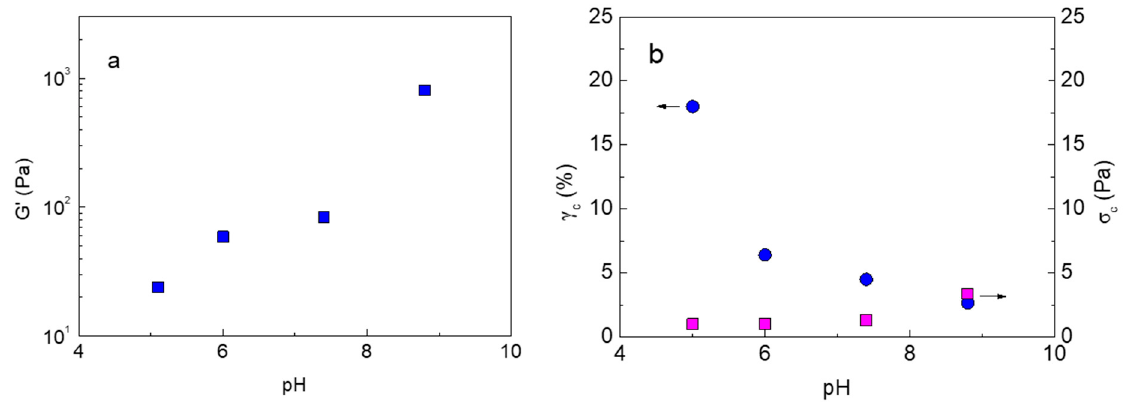
Figure 5. pH dependence of G’ (at 1 rad/s, from Figure 4a), ( a ) γ c (spheres) and σ c , (squares, from strain sweep data) ( b ) of PAA-g-P(b-LL) aqueous solutions of C p = 0.5 wt%.